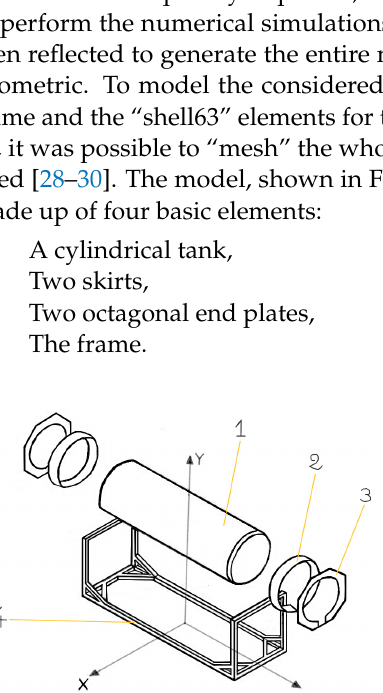
Figure 2. Mesh of the considered model. After to have realized the geometric model, the numerical simulations of the experi- mental tests ISO for tank container, were performed, defining the constraints and the loads and obtaining the output values of the following: - Nodal displacements and rotations; - Normal and bending stresses along y and z; -